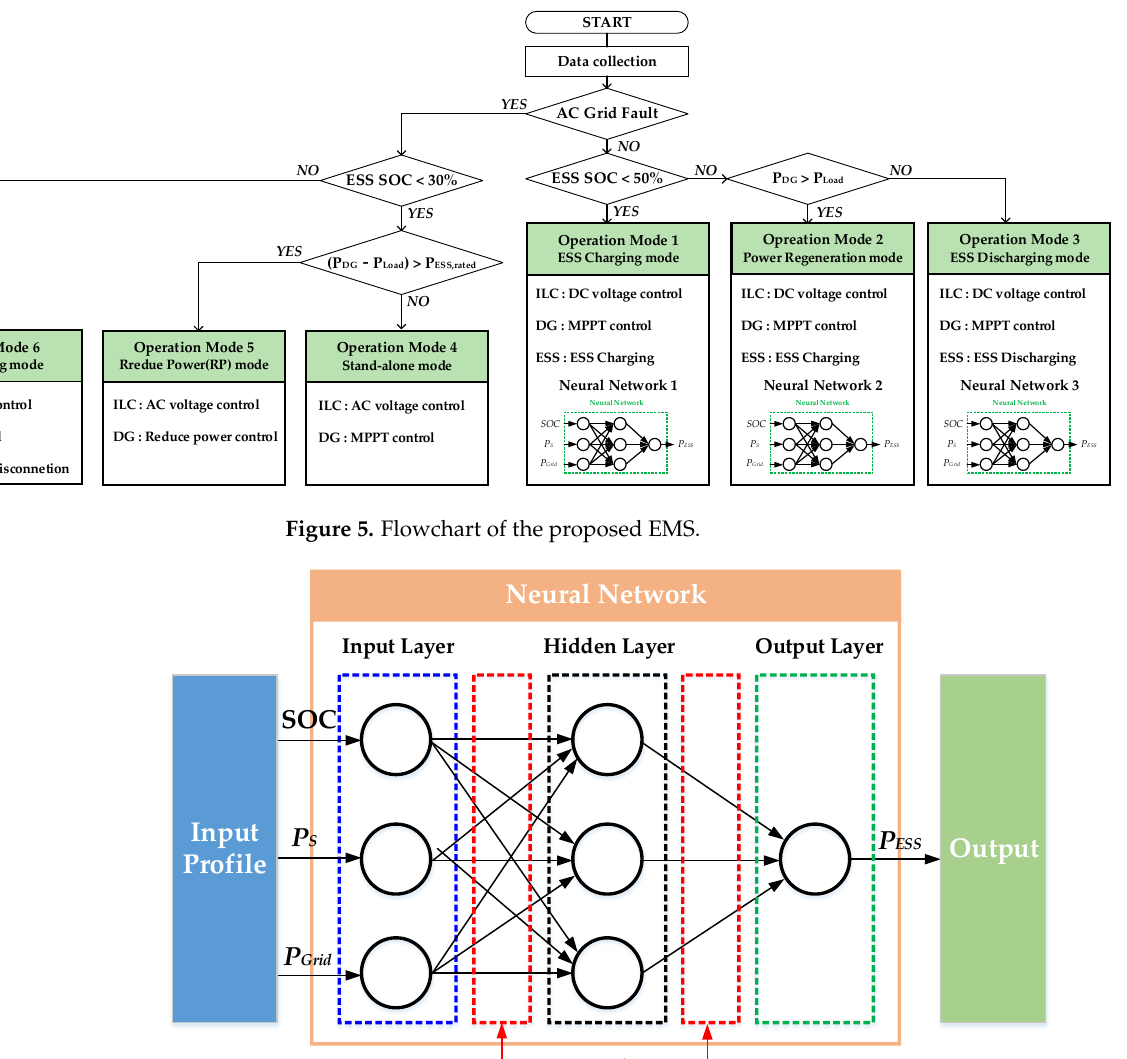
Figure 5. Flowchart of the proposed EMS.